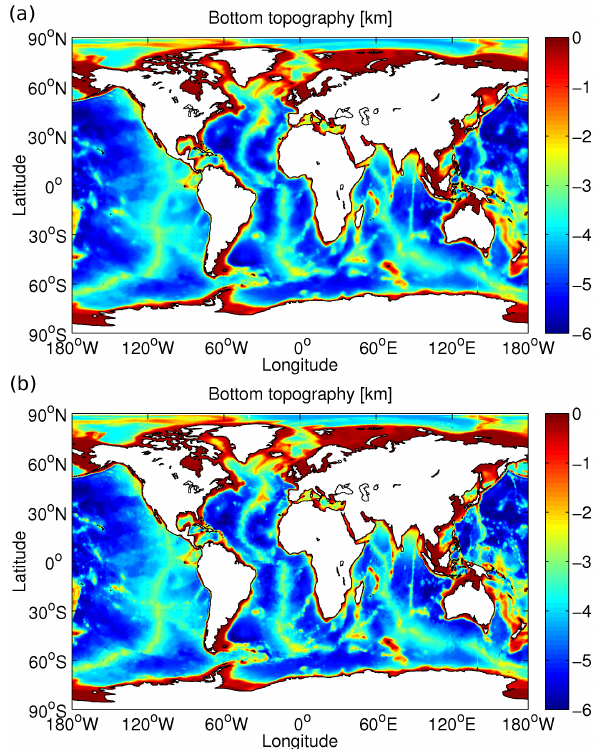
Fig. 16. Bottom topography (a) after three iterations of stencil filter Fig. 6. Bottom topography (a) after three iterations of stencil filter and (b) after a single iteration. and (b) after a single iteration.